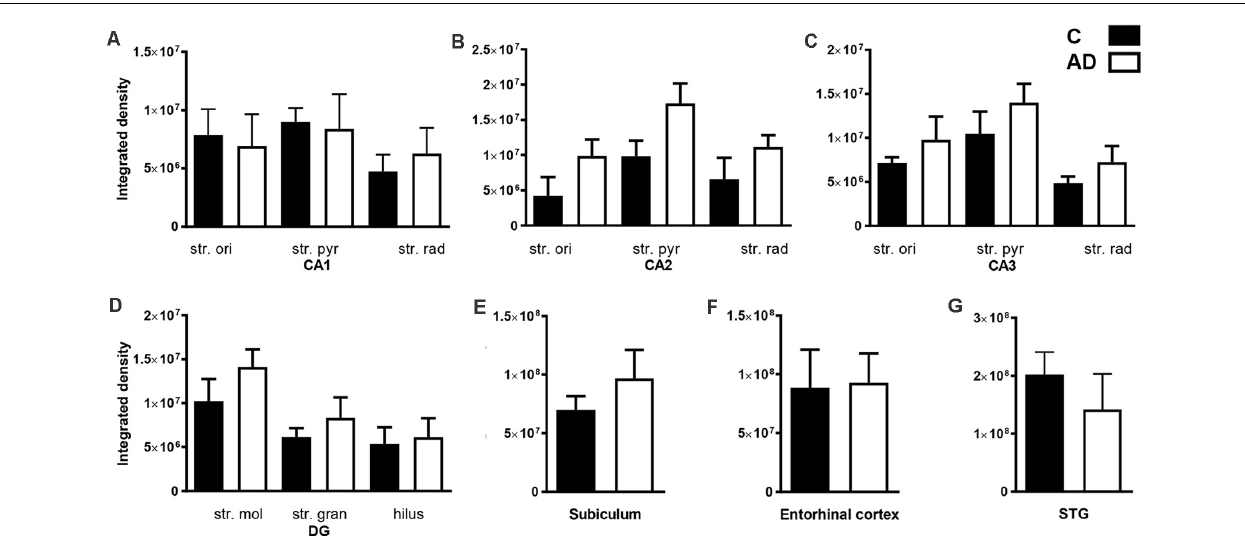
FIGURE 6 | Quantification of EAAT2 immunoreactivity within the CA1, CA2, CA3, dentate gyrus hippocampal subfields, subiculum, entorhinal cortex, and STG in control and AD groups. In the hippocampal CA1 (A) , CA2 (B) , CA3 (C) , DG (D) , subiculum (E) , entorhinal cortex (F) and STG (G) EAAT2 density shows no statistically significant change in AD (white bars; n = 6) compared to control (black bars; n = 7) cases (Unpaired Mann–Whitney test). Data are expressed as mean with error bars representing standard error of mean (SEM). AD, Alzheimer’s disease; C, control; CA, cornu ammonis; DG, dentate gyrus; STG, superior temporal gyrus, str. ori, stratum oriens; str. pyr, stratum pyramidale; str. rad, stratum radiatum; str. mol, stratum moleculare; str. gran, stratum